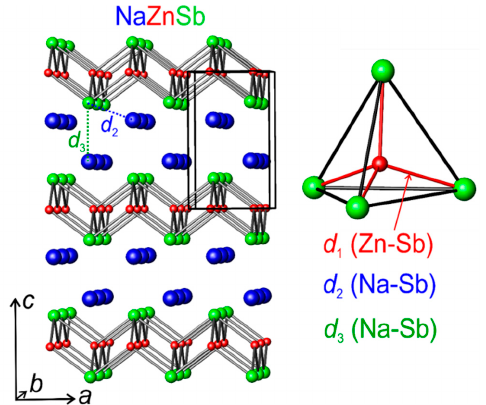
Figure 1. Crystal structure of NaZnSb. The tetrahedral coordination of Zn by four Sb atoms is shown on the right. The selected interatomic distances are color coded. Atom color coding: Na, blue; Zn, red; Sb,